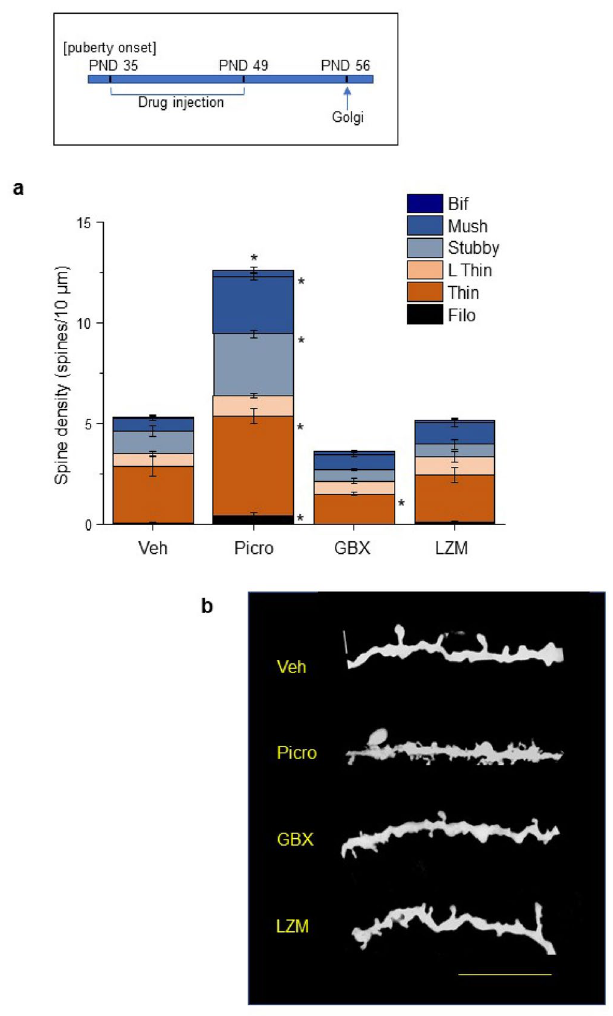
Figure 3. Pharmacological manipulation of GABAR-gated current during puberty alters spine density post- pubertally. Inset, timeline of drug administration during the pubertal period of high α4 expression (PND 35–49) using picrotoxin (PICRO, 3 mg/kg, i.p.), gaboxadol (GBX, 0.1 mg/kg,i.p.), lorazepam (LZM, 0.25 mg/kg, i.p.) or vehicle (VEH). Mice were euthanized for Golgi procedures on PND 56. ( a ) Averaged data, Total spines, F(3,22) = 119.5, P < 0.0001 [Veh vs. Picro, *P < 0.0001]; mushroom, F(3,22) = 25.53, P < 0.0001 [Veh vs. Picro, *P < 0.0001]; stubby, F(3,22) = 43.76, P < 0.0001 [Veh vs. Picro, *P < 0.0001]; thin, F(3,22) = 15.45, P < 0.0001 [Veh vs. Picro, *P = 0.0019; Veh vs. GBX, *P = 0.0445]; filopodia, F(3,22) = 4.71, P = 0.011 [Veh vs. Picro, *P < 0.02]. ( b ) Representative images of basal dendrites from Golgi-stained neurons from Post-pub female WT mice treated with the indicated drugs during puberty. Scale, 10 μm. n = 14–23 neurons, 7